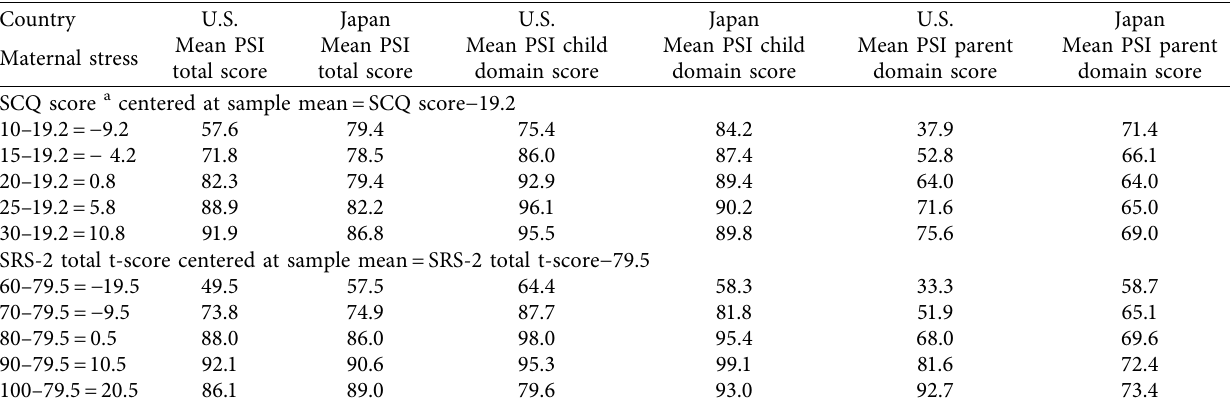
Table 4: Maternal parenting stress level based on mean parenting stress index (PSI) score and various examples of social communication questionnaire (SCQ) total scores and social responsiveness scale-2 (SRS-2) total T-scores by the country of residence using an interactive quadratic